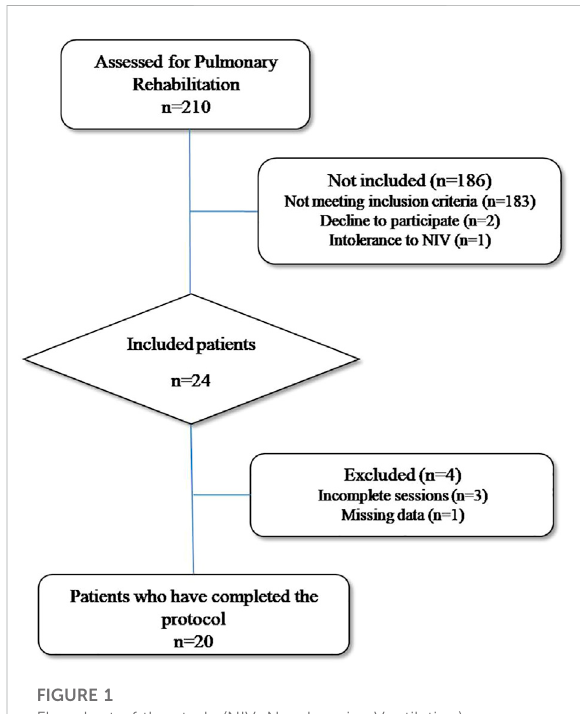
FIGURE 1 Flowchart of the study (NIV: Non Invasive